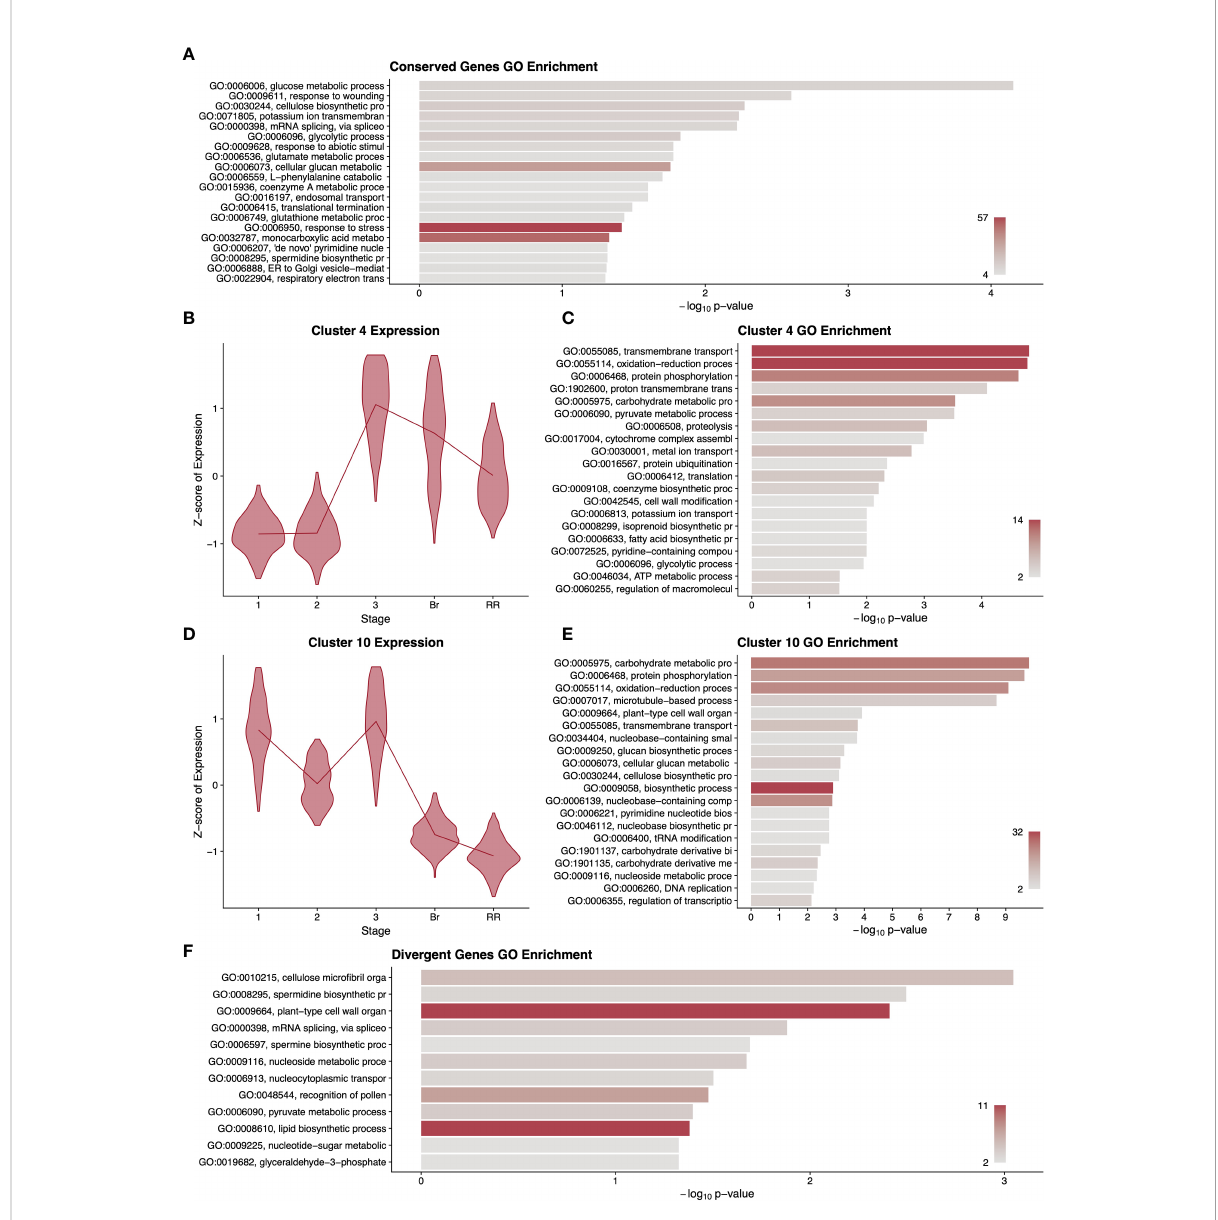
FIGURE 1 Summary of gene expression patterns conserved (A – E) or divergent (F) among cultivated and wild tomato. A gene ontology (GO) term enrichment analysis (A) performed on all differentially expressed genes without regard to species. Selected clusters of differentially expressed genes conserved among species are described with violin plots of normalised expression at each stage of development (B, D) and with GO enrichment analyses (C, E) , corresponding to 1415 and 1825 genes respectively. For differentially expressed genes with divergent expression between the species, we performed a GO enrichment analysis (F) . GO term descriptions to the left of the enrichment graphs are truncated for space and sorted by p-value. The bars are colored by the number of genes assigned to each GO term with legends in the lower right of each graph. Stages offruit development in the axis of B and D are numbered sequentially followed by “ Br ” for breaker stage and “ RR ” for red ripe